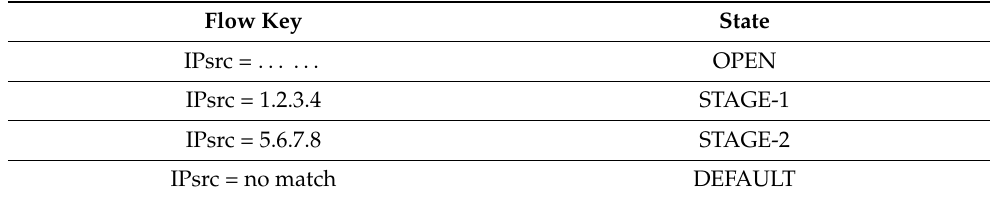
Table 1. Record states in the match–action table. Flow